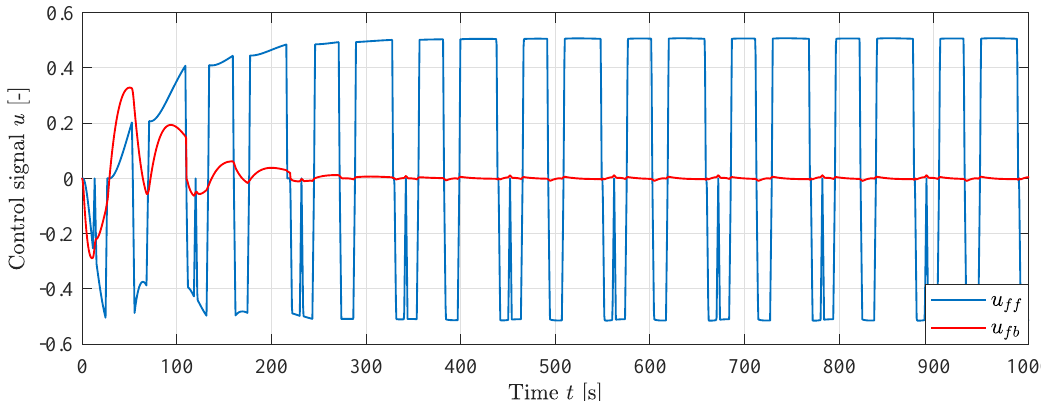
Figure 18. Control signals from feedforward and feedback during simulation, γ = 200 s · m − 3 .